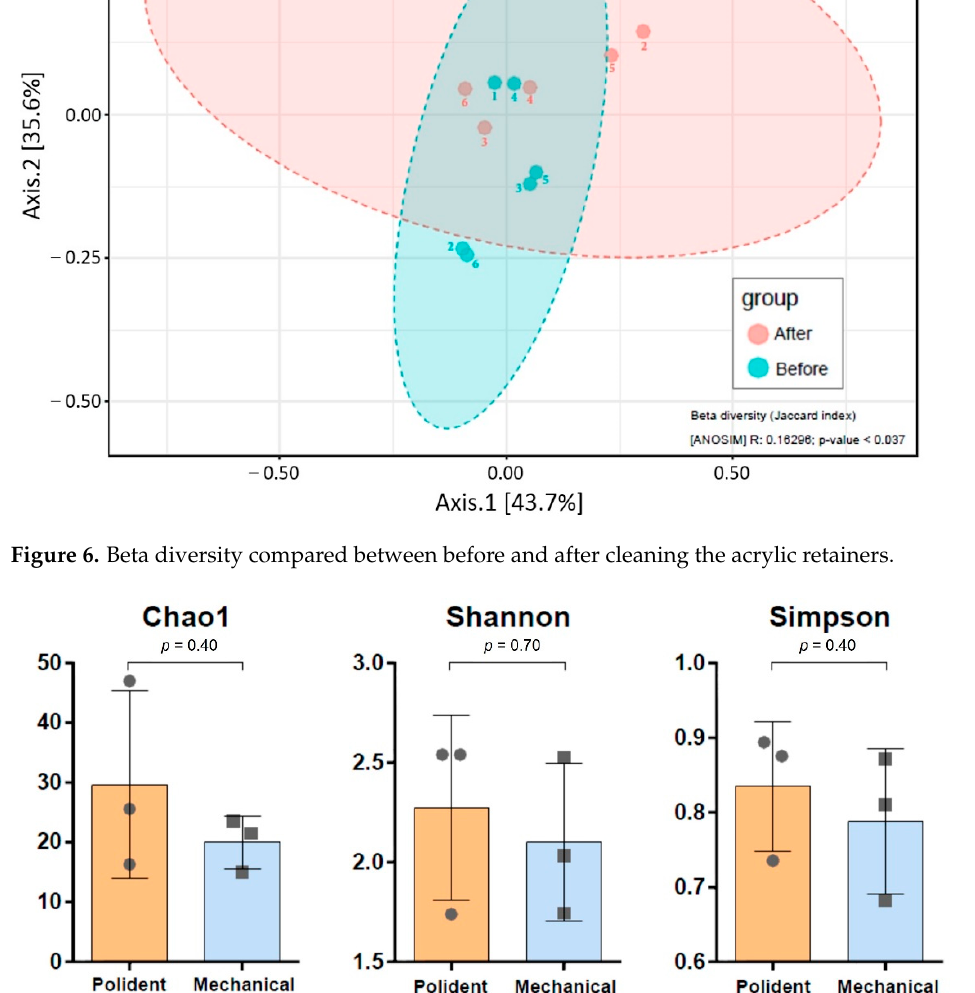
Figure 7. Alpha diversity compared between the chemical tablet and the brushing groups.